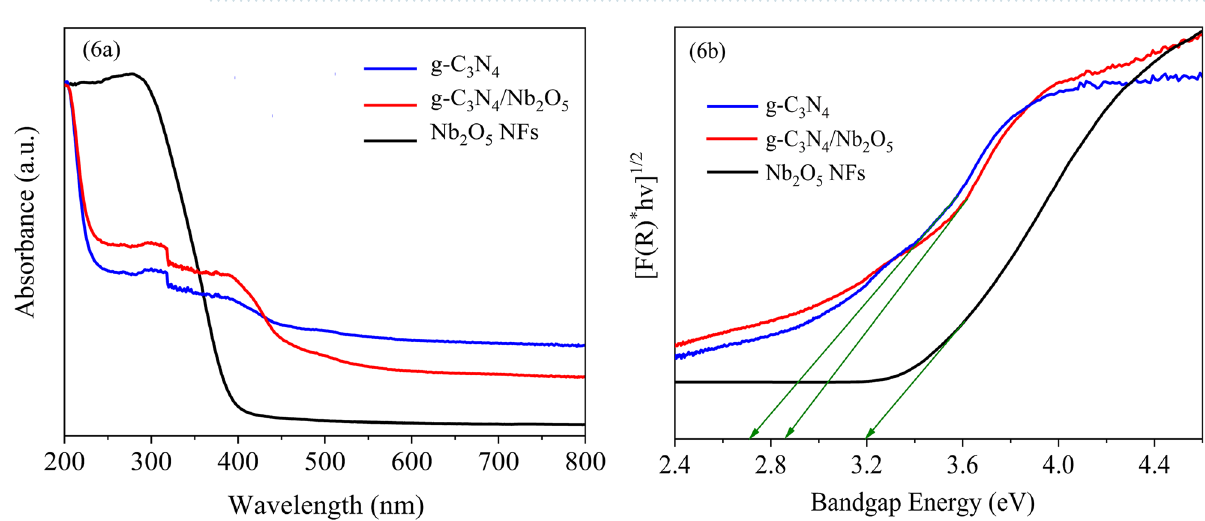
Figure 6. ( a ) UV–vis diffused reflectance spectra and ( b ) Tauc plot graph of g-C 3 N 4 , Nb 2 O 5 NFs and g-C 3 N 4 /